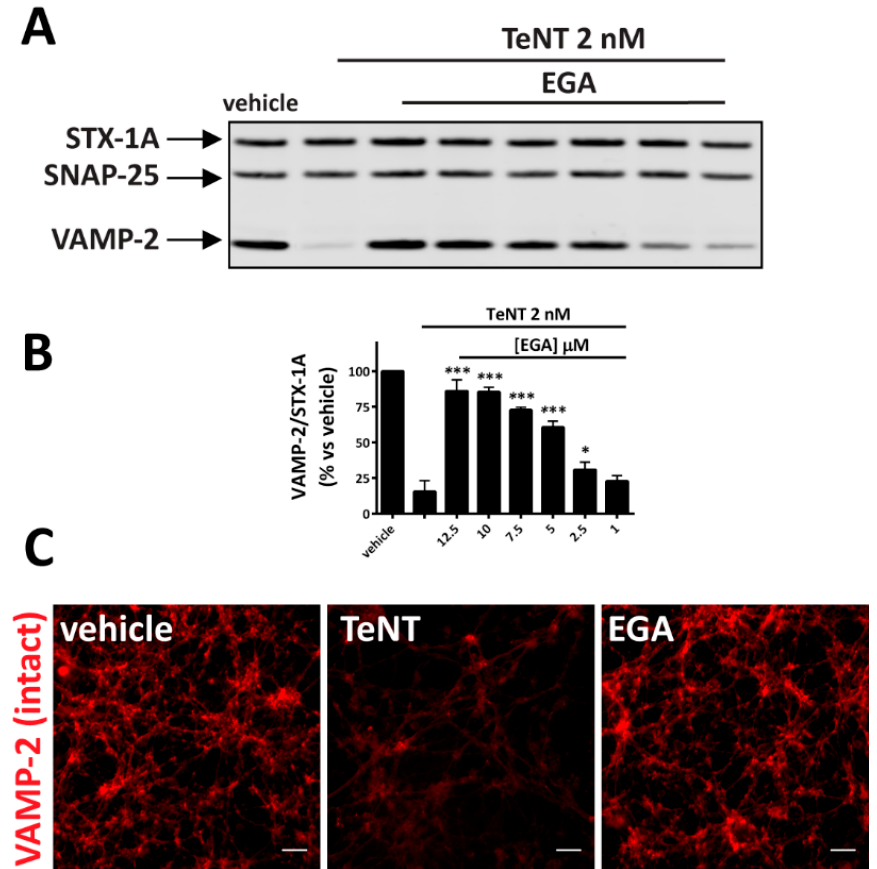
Figure 2. EGA prevents the TeNT-induced cleavage of VAMP-2 in cultured neurons. CGNs were incubated with different concentrations of EGA at 37 ◦ C for 30 min. TeNT 2 nM was added for 10 min, cells were washed, and culture medium with the same concentration of inhibitor was restored. Incubation was then prolonged for 4 h at 37 ◦ C. ( A ) Representative immunoblot showing the relative amount of VAMP-2, SNAP-25 and Syntaxin-1A in CGNs in control conditions (vehicle), upon treatment with TeNT alone (PC) and upon pre-treatment with decreasing amounts of EGA before TeNT addition. ( B ) Quantification of VAMP-2 signal in Western blots reported as a percent vs. vehicle and calculated as a ratio of STX-1A staining used as loading. SD values derive from three independent experiments. Graphs show mean ± SD. Significance was calculated by a two tailed Student’s t -test compared to neurons treated with TeNT alone (*** p < 0.001; * p < 0.05) ( C ) Representative immunofluorescence for VAMP-2 staining in CGNs treated as in ( A ). EGA was used at 12.5 µ m. The image is representative of three independent experiments. Scale bar is 20 µ